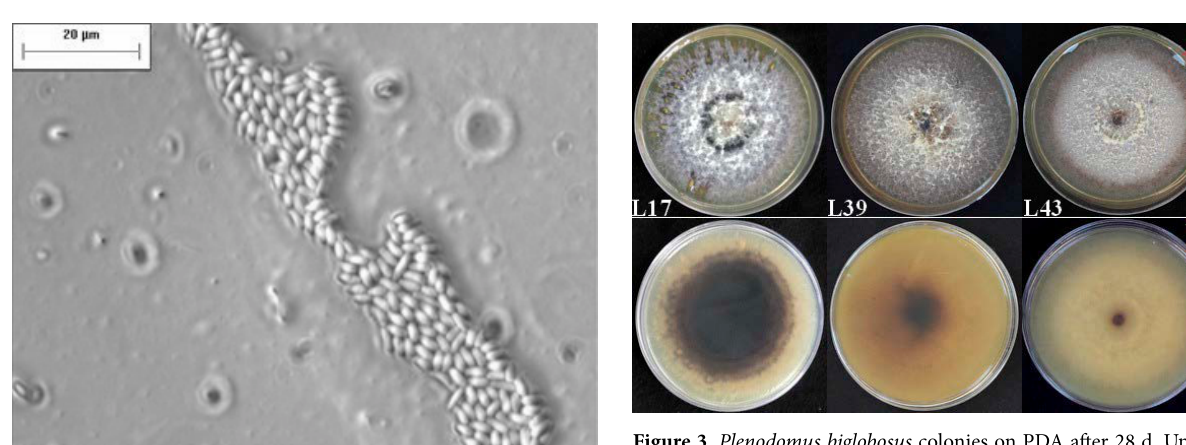
Figure 3. Plenodomus biglobosus colonies on PDA after 28 d. Upper surface (A) and lower surface